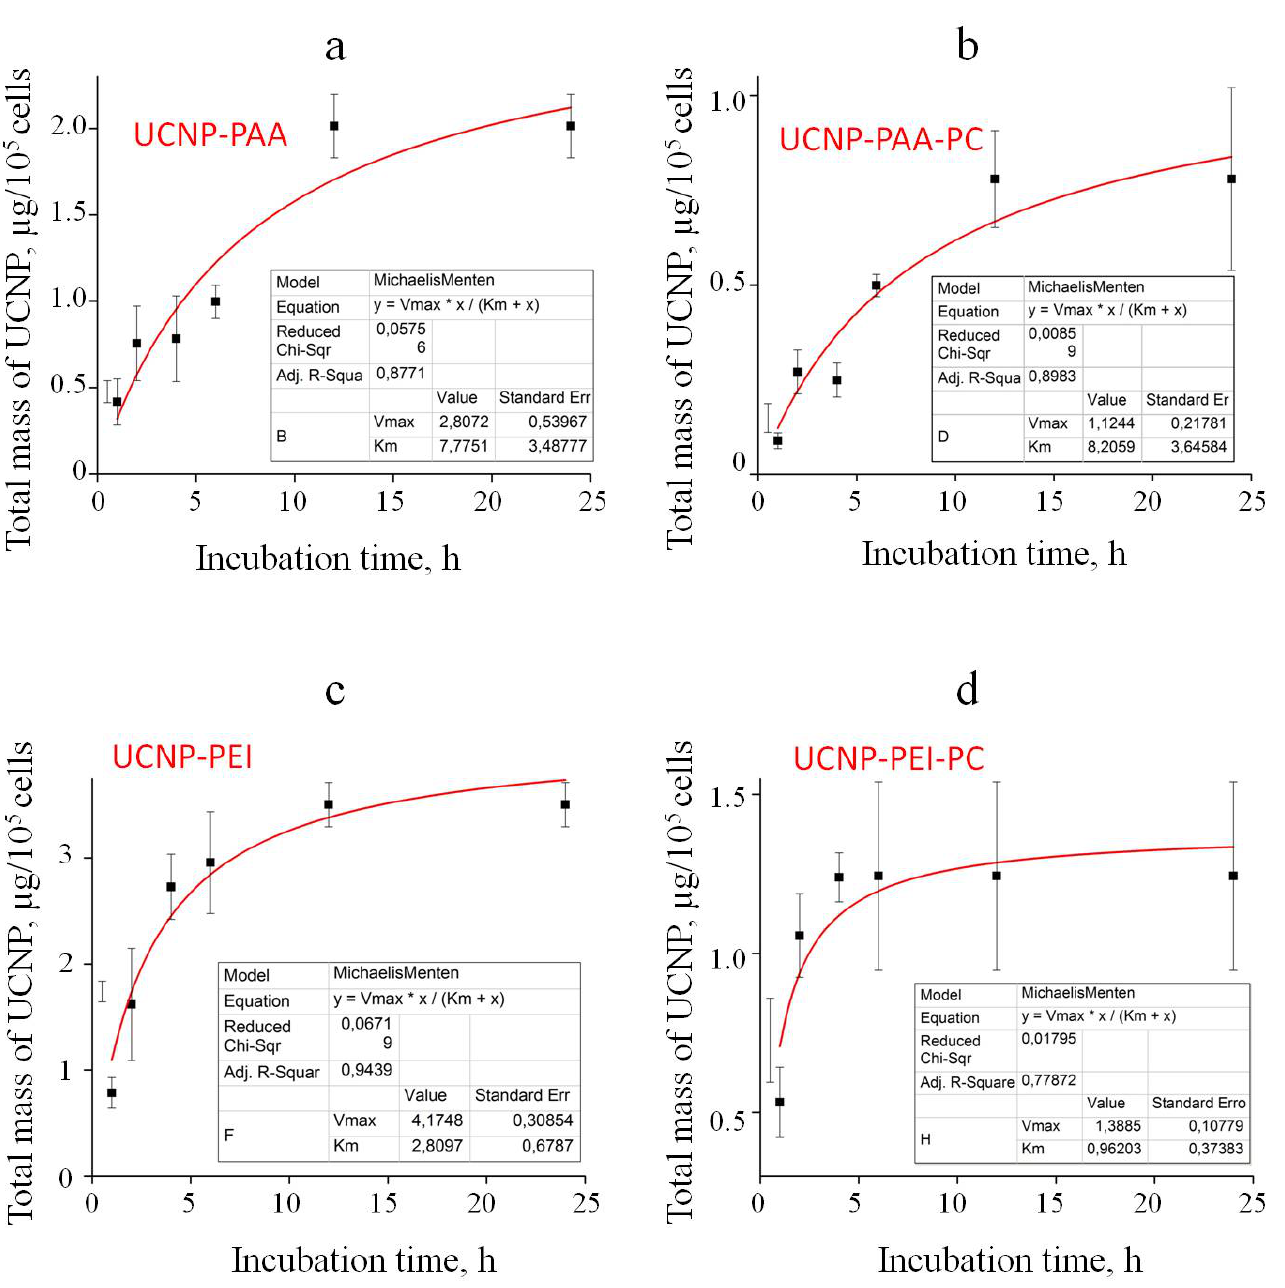
Figure 7. Plots of the kinetics of the UCNP association with MDA-MB-231 cells (data shown in Figure 6a) fitted with the Michaelis–Menten function for UCNP-PAA ( a ), UCNP-PAA-PC ( b ), UCNP- PEI ( c ), and UCNP-PEI-PC ( d